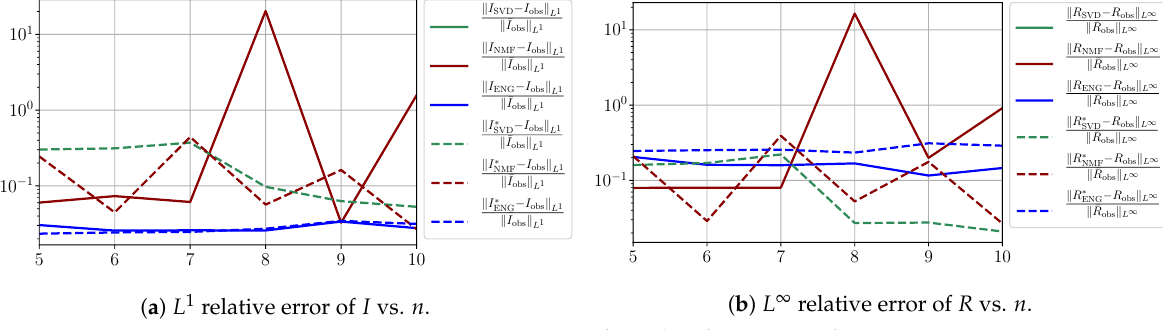
Figure A9. Forecasting errors of I and R (from T = 01/04).